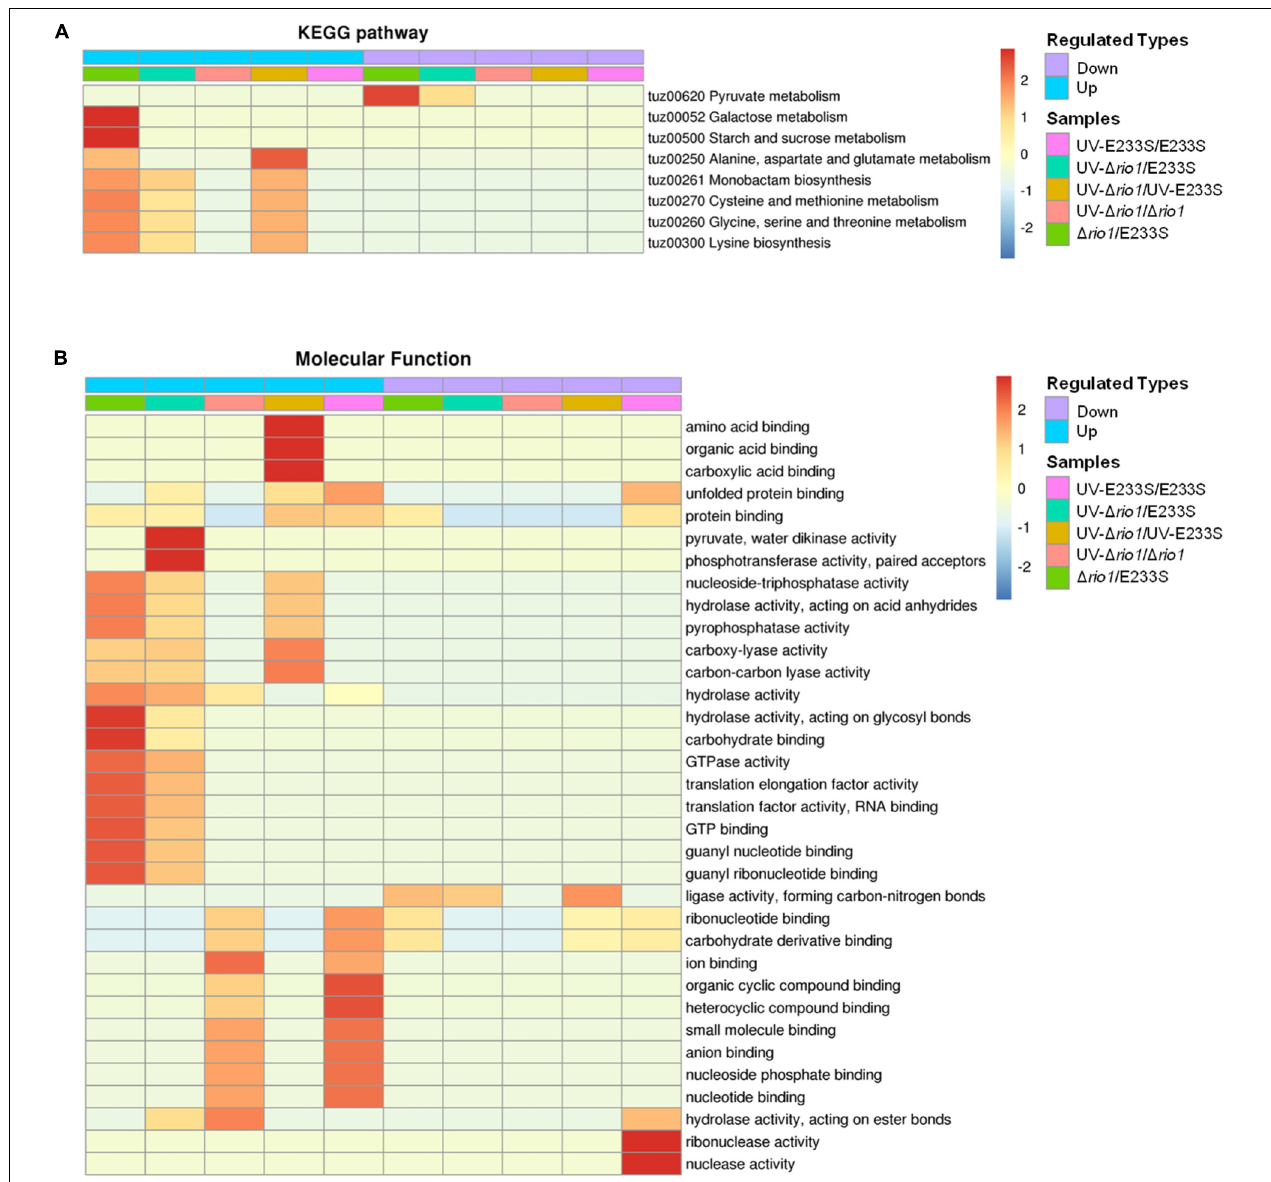
FIGURE 7 | Functional enrichment of the five comparison groups. (A) KEGG pathway. (B) Molecular function. Both increase (up) and decrease (down) of differentially phosphorylated proteins involved in processes or pathways are shown. Red to blue represents the enrichment strength in log10